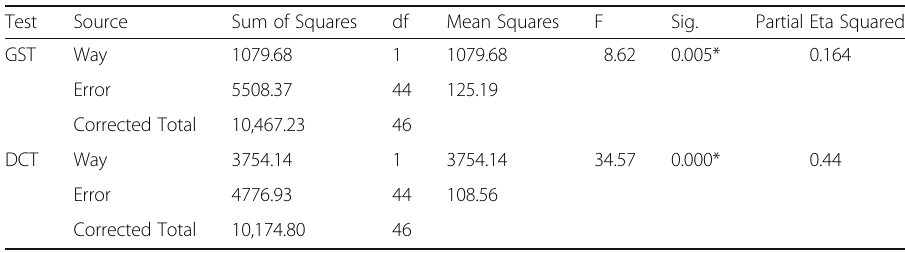
Table 2 ANCOVA of the Students ’ Scores on the Post- GST and